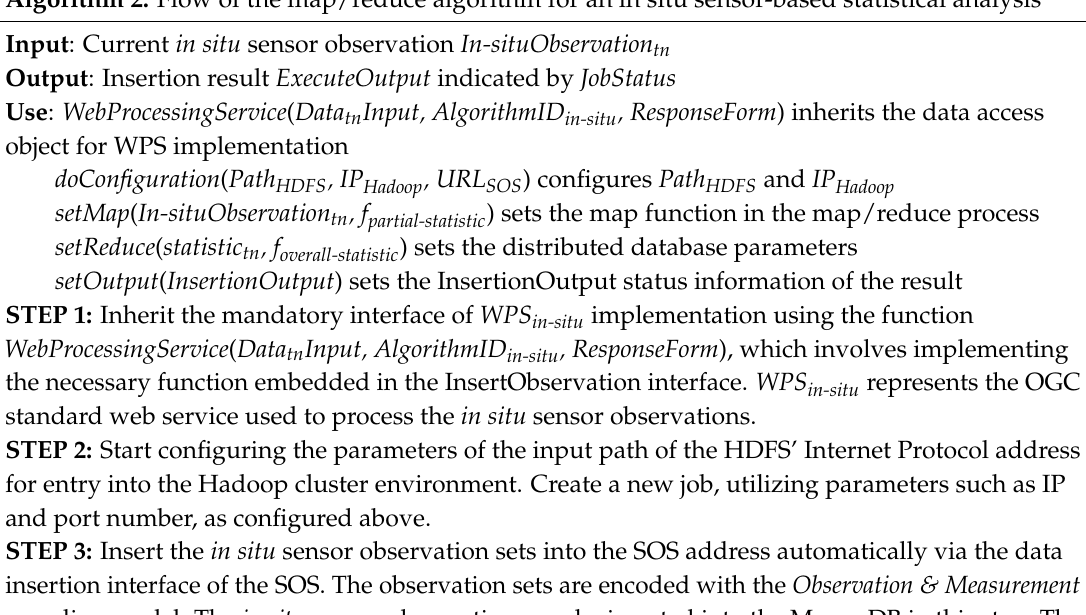
Algorithm 2. Flow of the map/reduce algorithm for an in situ sensor-based statistical